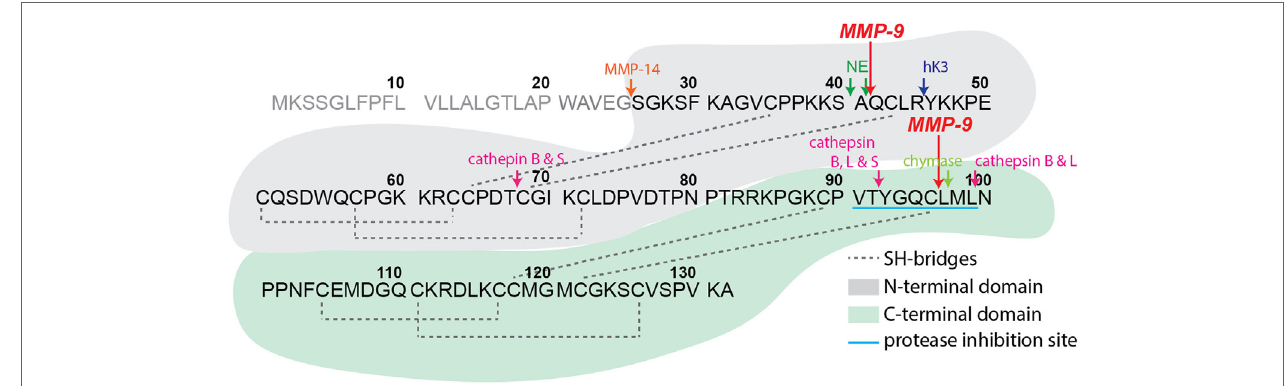
FigUre 1 | Secretory leukocyte peptidase inhibitor (SLPI) structure and proteolysis. Schematic representation of human SLPI (GenBank: CAA28187.1) structure, protein sequence, and experimentally confirmed protease digestion sites. SLPI contains two structurally similar domains, here colored in gray (N-terminal domain) and green (C-terminal domain) backgrounds. The C-terminal domain contains the main amino acid sequence for SLPI protease inhibition properties (sequence VTYGQCLML with blue underlining). Experimentally determined protease digestion sites are indicated by arrows and corresponding proteases marked above. The signal peptide sequence residues 1–25 are in gray. The experimental cleavage sites by matrix metalloproteinase-9 from the present study are indicated by large red arrows.